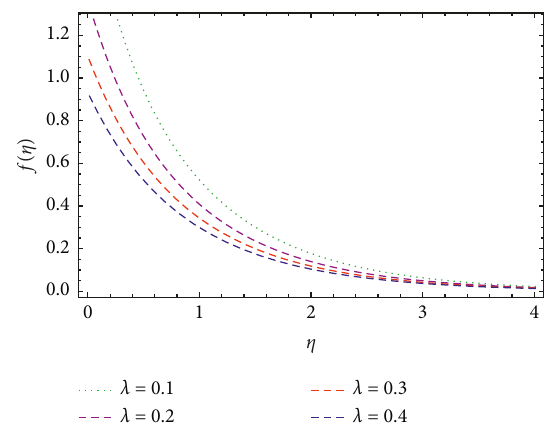
Figure 8: The influence of the velocity profile for different values of λ , when K � 0 . 1 ,f w � 0 . 3 , β � 0 . 2 , Pr � 5 . 0 ,E c � 0 . 4 , and a ∗ � b ∗ � 0 . 2